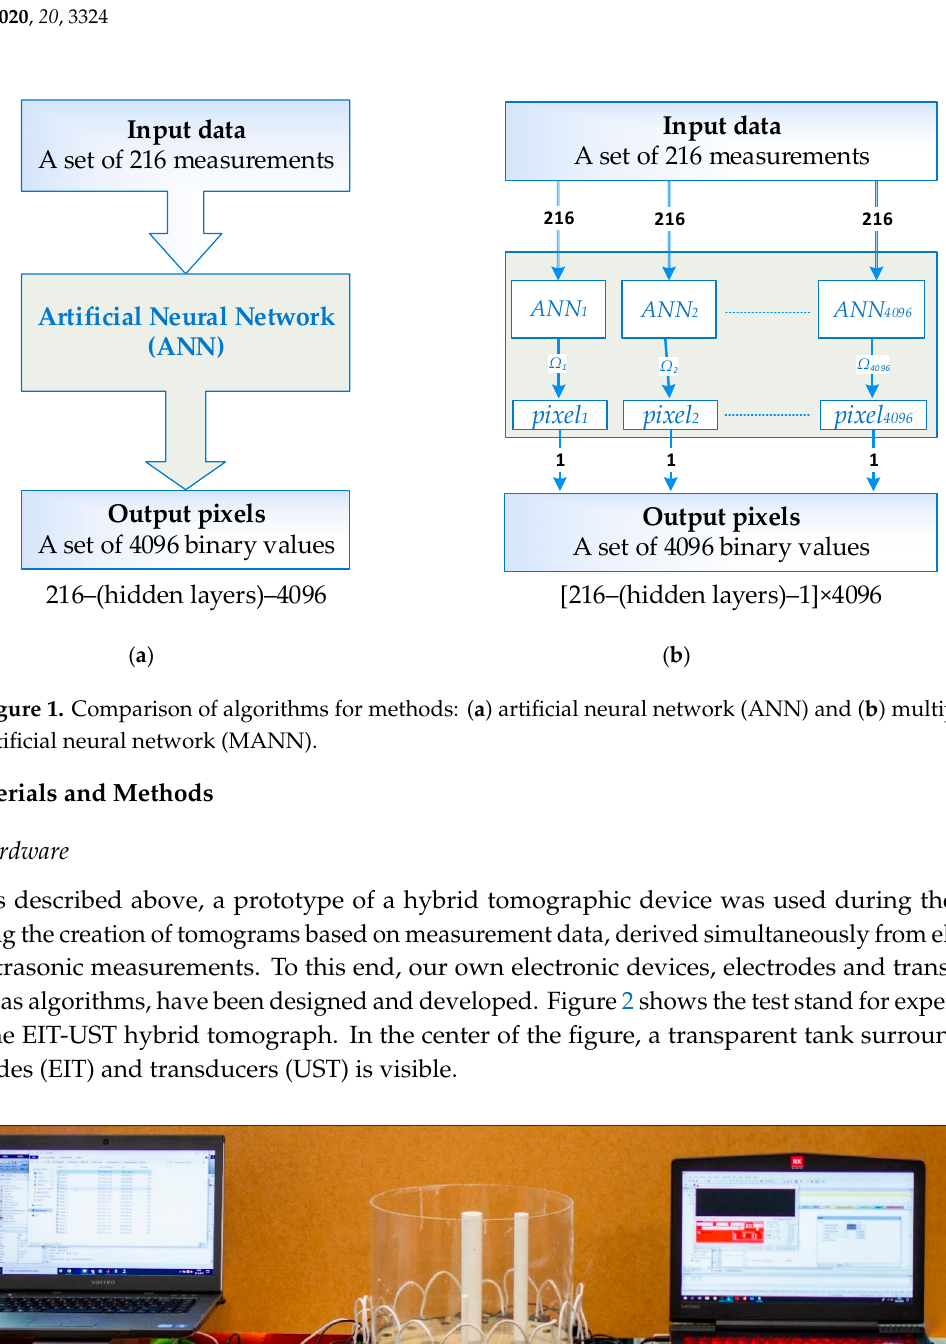
(c) Figure 3. Research object: ( a ) tank with central inclusion, ( b ) connected electrodes and transducers, ( c ) inside the UST transducer. Despite the fact that EIT electrodes and UST transducers are elements of one system, each set of EIT and UST sensors collects data independently of the other. In order to reduce interference and noise generated during measurements, the hybrid tomograph controls the moments of individual measurements, so as not to take electrical and ultrasonic measurements at the same time. More information on tomographic devices used in research can be found in our previous publications [16,46]. 2.2. Electrical Impedance Tomography (EIT)